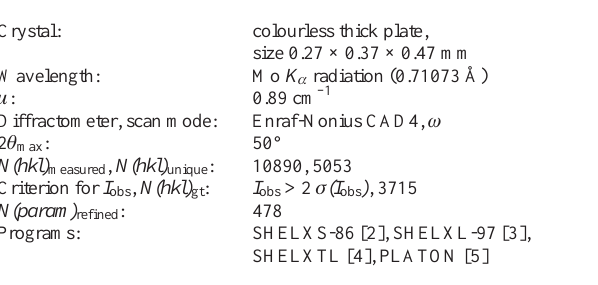
Table 1. Data collection and